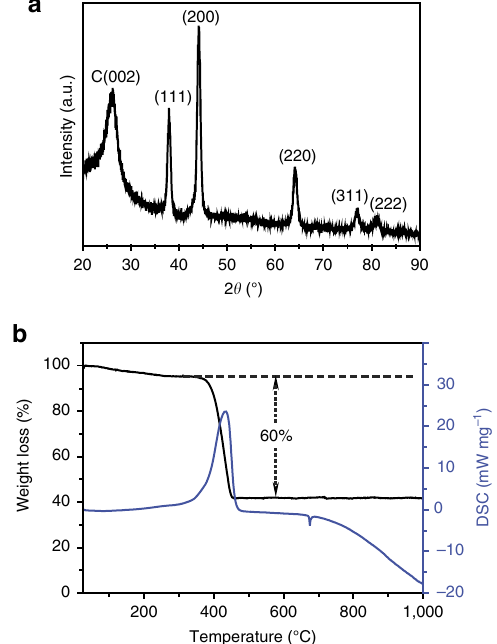
Figure 3 | Compositional information of the VN/G composite. ( a ) X-ray diffraction (XRD) pattern and ( b ) thermogravimetric-differential scanning calorimetry (TG-DSC) curve of the VN/G